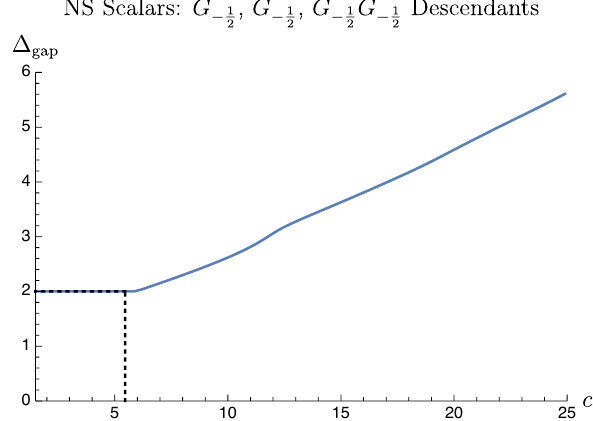
Figure 7: Upper bounds on the gap in the NS spectrum of scalar op- erators that are G − 1 charge is varied up to c = 25. The range of c in which the bound is at 2, marked by the dashed lines, indicate the necessary existence of a marginal or relevant deformation that preserved some supersym-